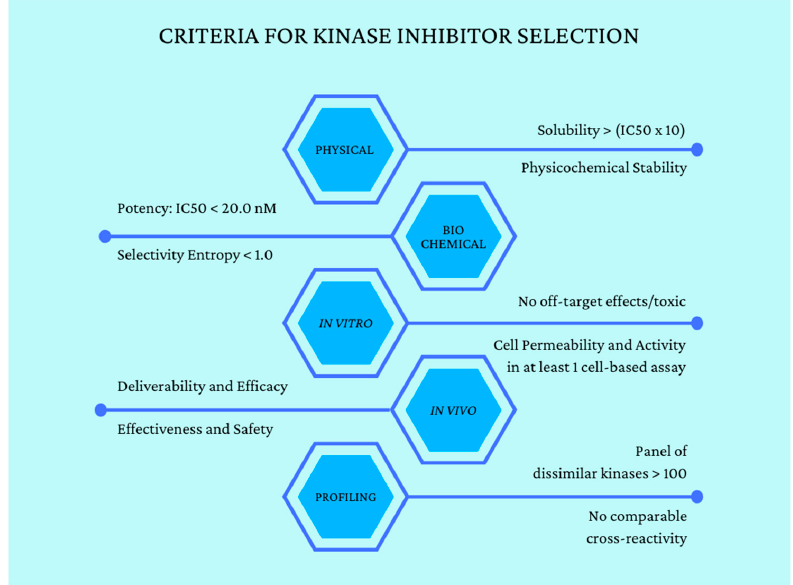
Figure 4. Standards for screening compound libraries for protein kinase inhibitor activity. Adapted from [64] .